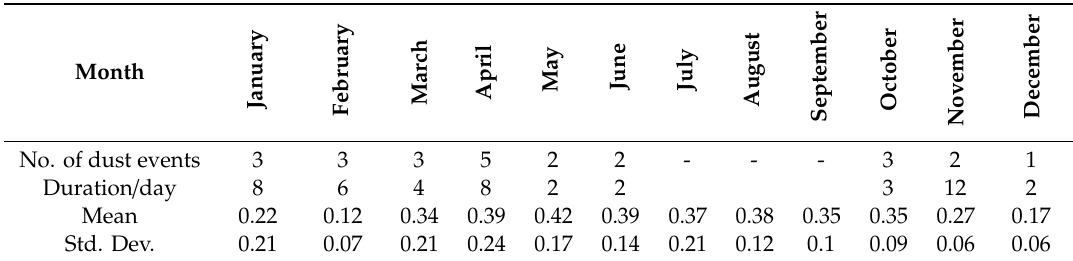
Table 3. Number of recorded dust events in 2016 from EEAA, with corresponding monthly mean MODIS AOD and standard deviation.